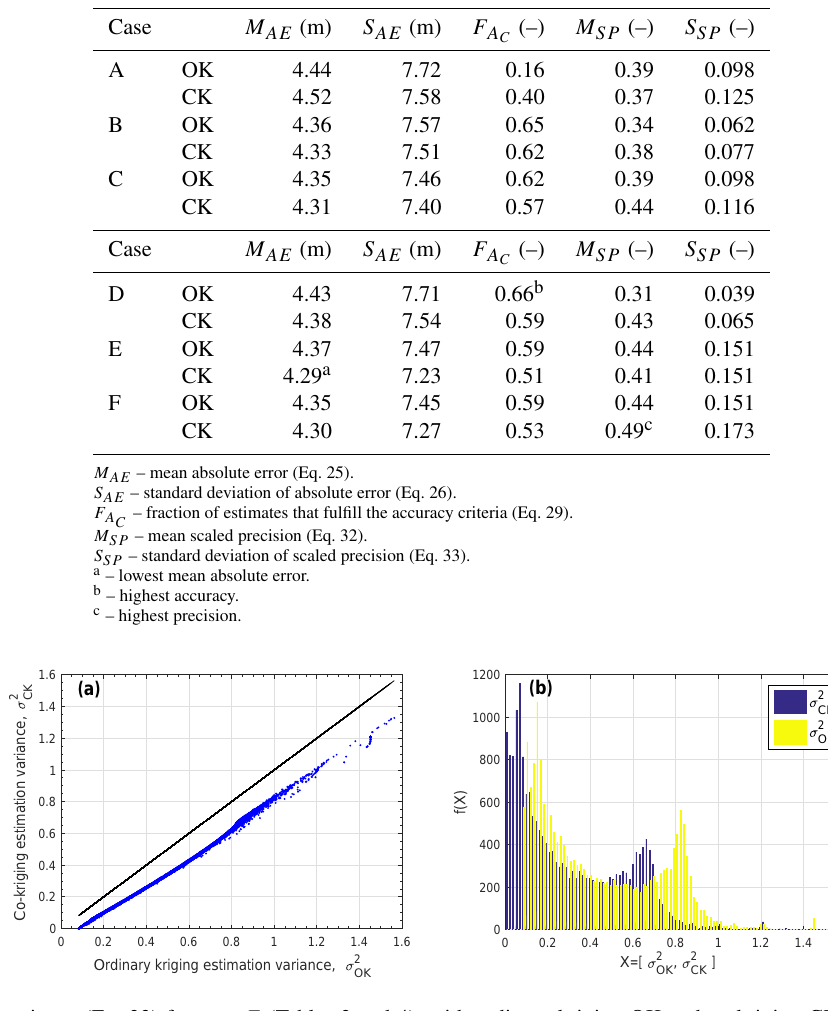
Figure 8. Estimation variance (Eq. 23) for case F (Tables 3 and 4), with ordinary kriging OK and co-kriging CK results. The scatter plot to the left (a) shows that CK estimation variances are lower than OK estimation variances. The black line indicates a 1 : 1 relation. The histograms to the right (b) show the estimation variance for OK and